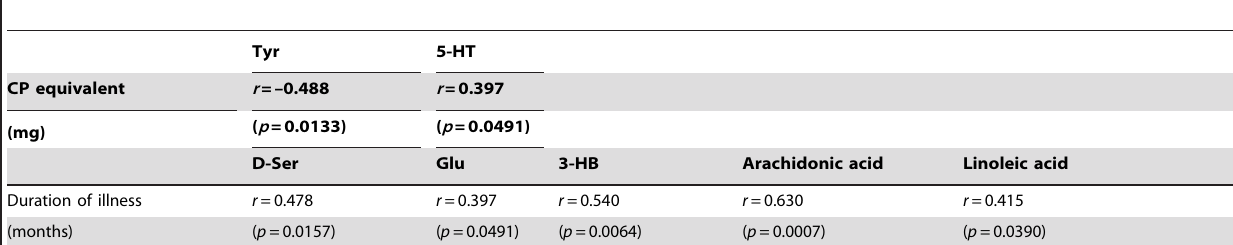
Table 3. Correlations between serum levels of metabolites and CP equivalent (mg) or duration of illness (months).